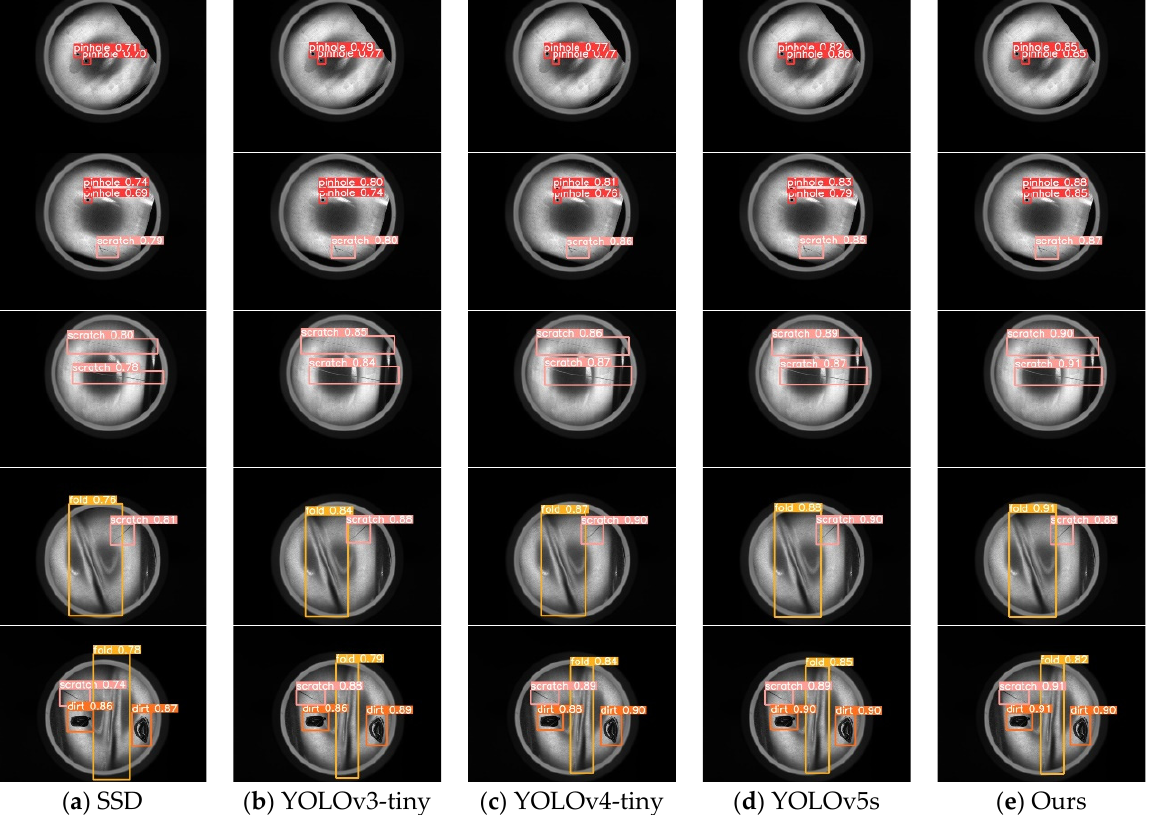
Figure 8. Visual comparison of the results of the five algorithms on the